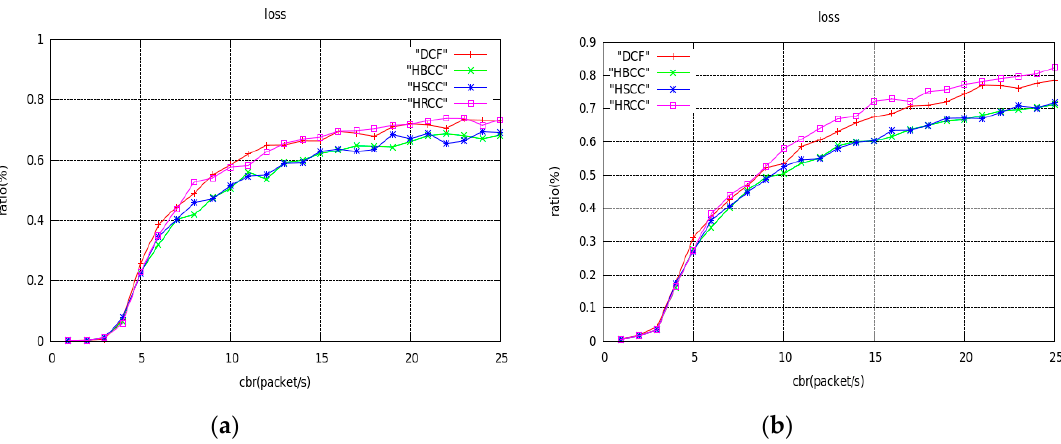
Figure 16. Buffer overflow packet loss ratio curves of random network topology. ( a ) The topology of Figure 14a; ( b ) The topology of Figure 14b.